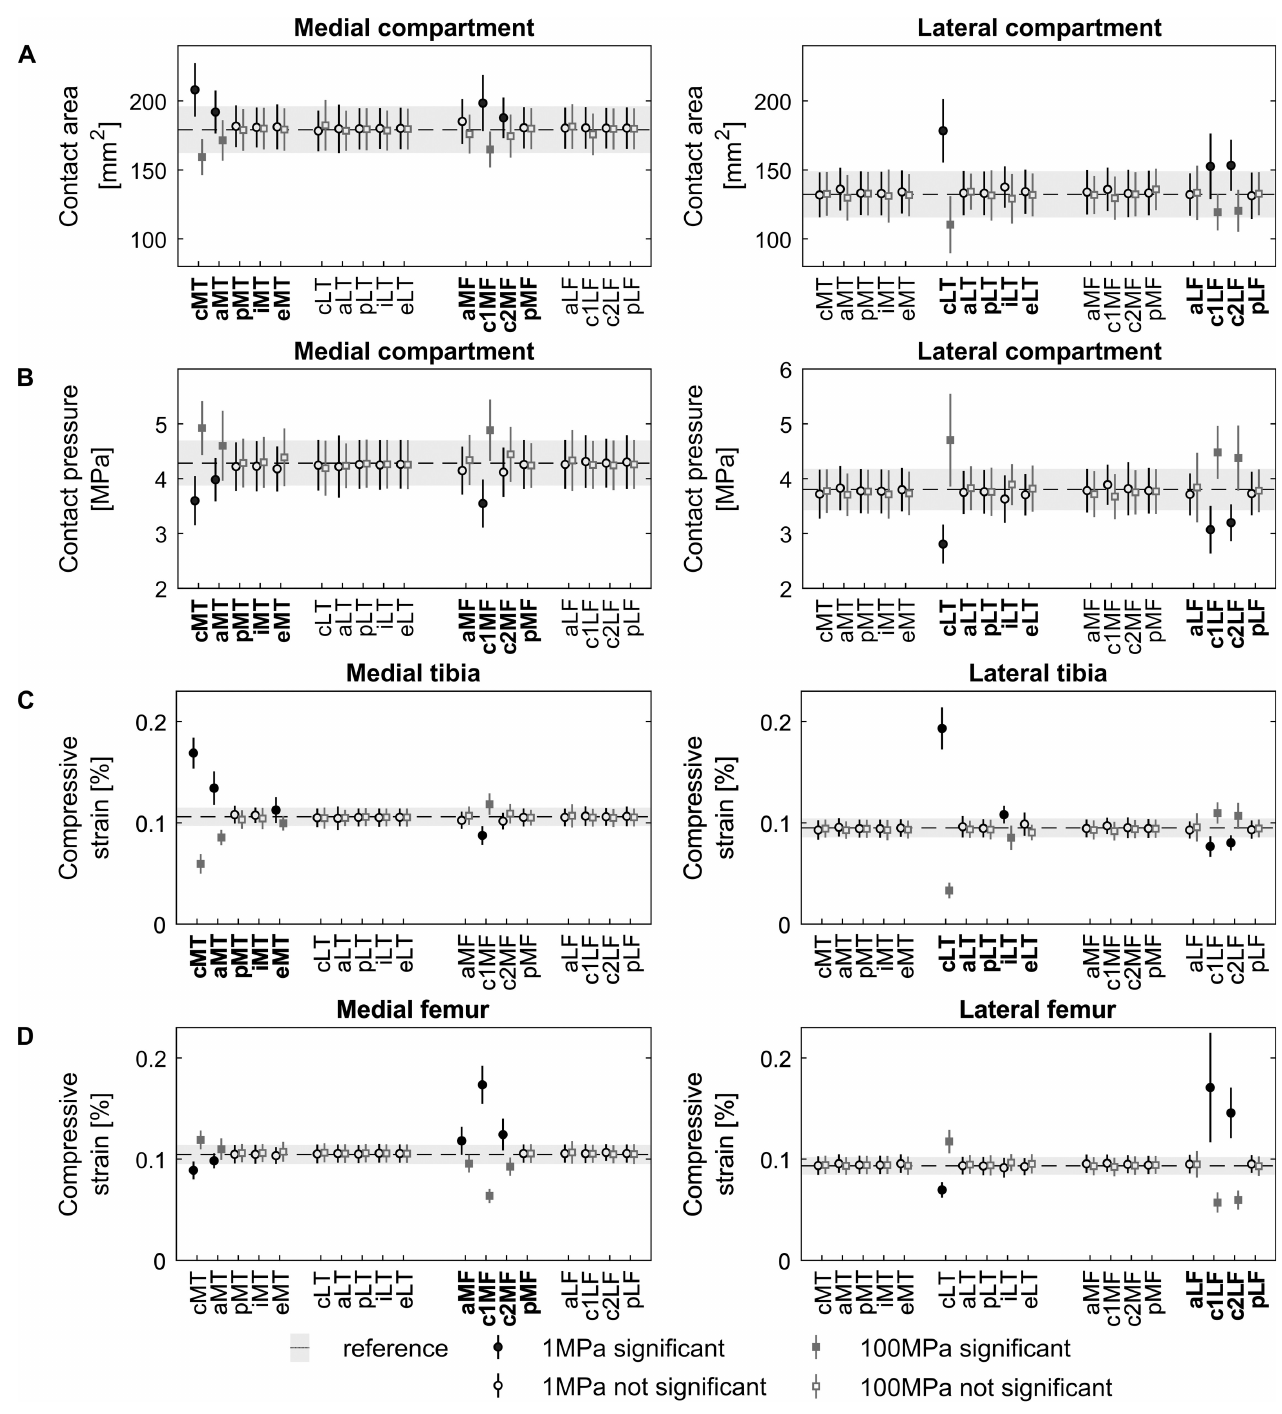
Fig 3. Effect of cartilage defect location and stiffness on compartmental load and compressive strain distribution. Average tibiofemoral contact area (A), pressure (B) and compressive strain in the tibia (C) and femur (D) for the different cartilage defect locations (Fig 1) throughout the stance phase of gait in the medial and lateral compartment of the tibiofemoral joint. The contact area was scaled to knee dimensions (scale factor 2 ). Bold labels on the x-axis indicate defects located in the compartment used in the analysis. The dashed black line and shaded light-gray area indicate the mean and standard deviation of the reference simulations (n = 30). The black and dark-gray error bars represent the cartilage softening (1MPa) and hardening (100MPa) at the defect location, respectively. Filled marker signs indicate significant differences compared to the reference simulation (light-gray bar) at 5% significance level.